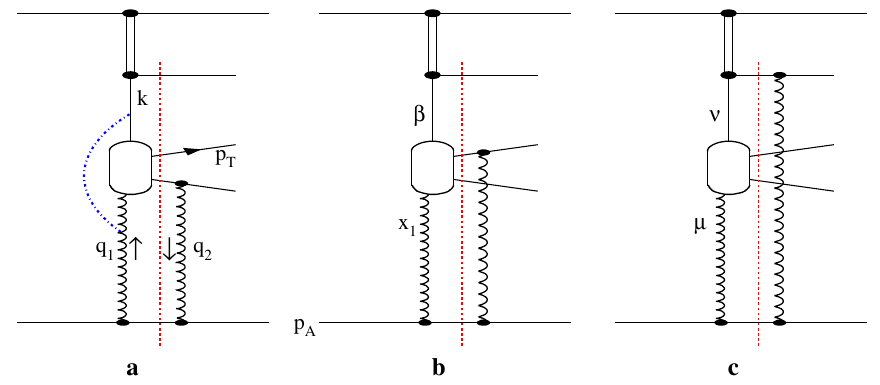
Fig. 3 Three diagrams which describe the imaginary part of exclusive 3-jet production amplitude. The momenta, q 1 , 2 , of incoming gluons from the hard Pomeron and the parton, k , from the soft Pomeron are indicated in a ; p T is the hard jet momentum. Momentum fractions, x 1 ,